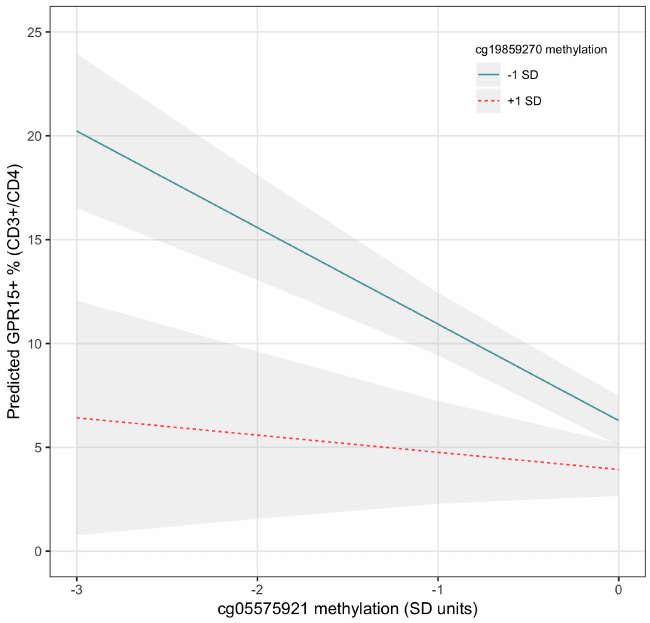
Figure 4. Interaction of cg05575921 and cg19859270 methylation in predicting GPR15 + T h cell percent. The interaction is visualized by plotting regression lines for cg05575921 while holding the value of cg19859270 at 1 SD above and below its mean. Regression coefficient values are taken from Model 2D, Table S3. The ribbons indicate the model-based 95% confidence intervals for each regression line.